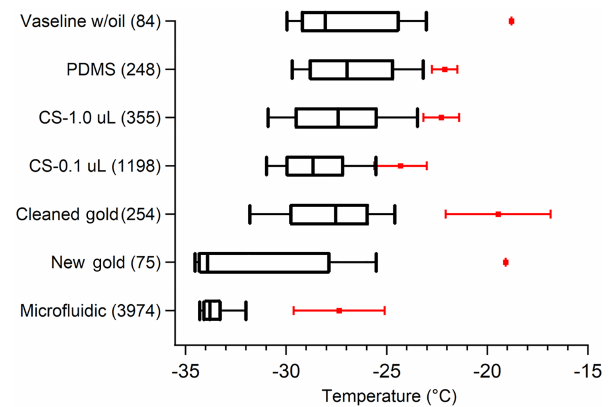
Figure 11. Summary of pure water droplet freezing spectra for different substrates tested. Boxes show the 25% and 75% frozen quartiles and the median, N 50 , is indicated by the line inside each box. Red markers are the temperatures of the first onset freezing droplets with error bars showing variability between different repli- cate droplet arrays. CS represents droplets on a silanized glass cover slip. No error bars for the onset freezing for Vaseline and gold wafer are shown because only one array was run of each. Whiskers show the 10% and 90% droplet frozen fractions. Next to each substrate name in parentheses is the number of droplets tested. Filtered HPLC water droplets produced by an electronic pipette were used in all of these measurements, except for the microfluidic chip which gener- ated the droplets on-chip. Droplets were 0.1µL in volume, except for the 1.0µL on the cover slip, and the 6nL droplets created in the microfluidic chip.